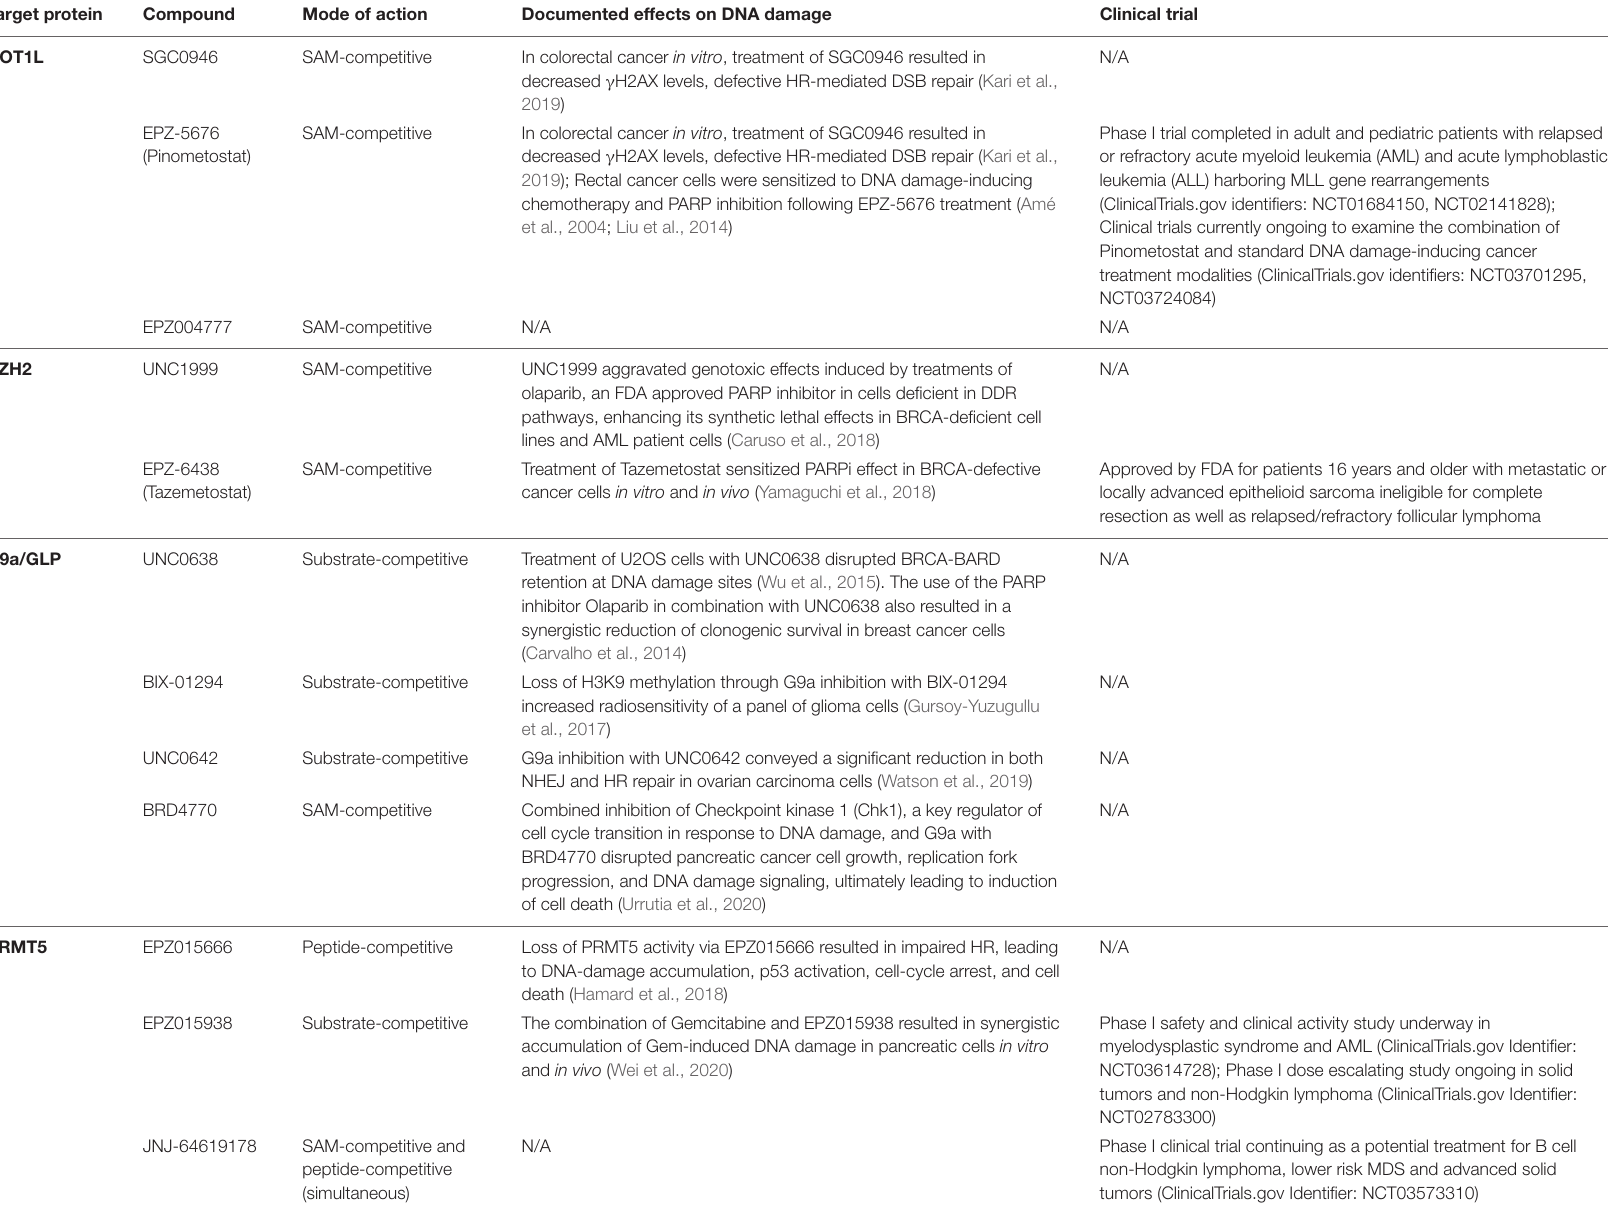
TABLE 1 | Small molecule inhibitors of DOT1L, G9a/GLP, EZH2, and PRMT5 and their anticancer activities in relation to DNA damage repair. Target